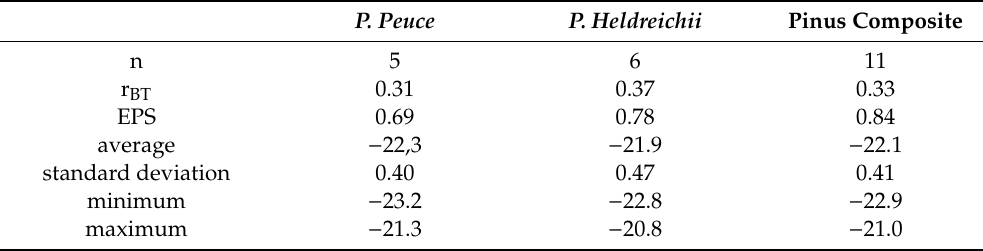
Figure 5. Stable carbon isotope ratio chronology of P. peuce and P. heldreichii (black and grey dotted line) and Pinus composite—composite chronology of P. peuce and P. heldreichii (solid black line). Table 5. Descriptive statistics: Expressed population signal (EPS) and average Pearson’s correlation coe ffi cient (r BT ) among individual trees included in δ 13 C chronologies from sites Murina ( P. heldreichii ) and Hridsko ( P. peuce ). Columns 2 and 3 ( P. peuce and P. heldreichii ) show statistical descriptors for each of the δ 13 C chronologies, the last column (4) shows descriptive statistics for the composite δ 13 C chronology (Pinus